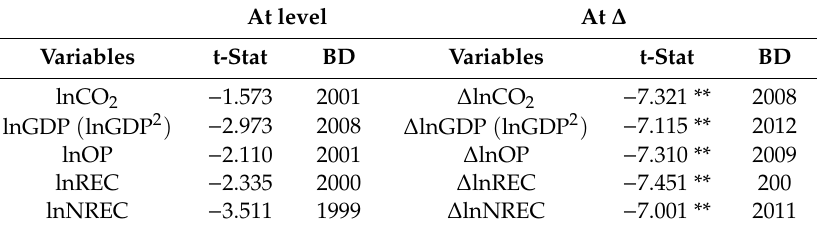
Table 2. The Perron–Vogelsang test results.